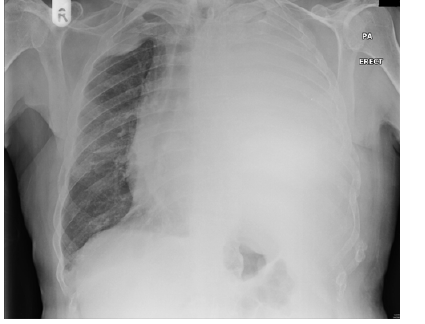
Figure 1. Chest radiographs showed a large left sided pleural effusion.